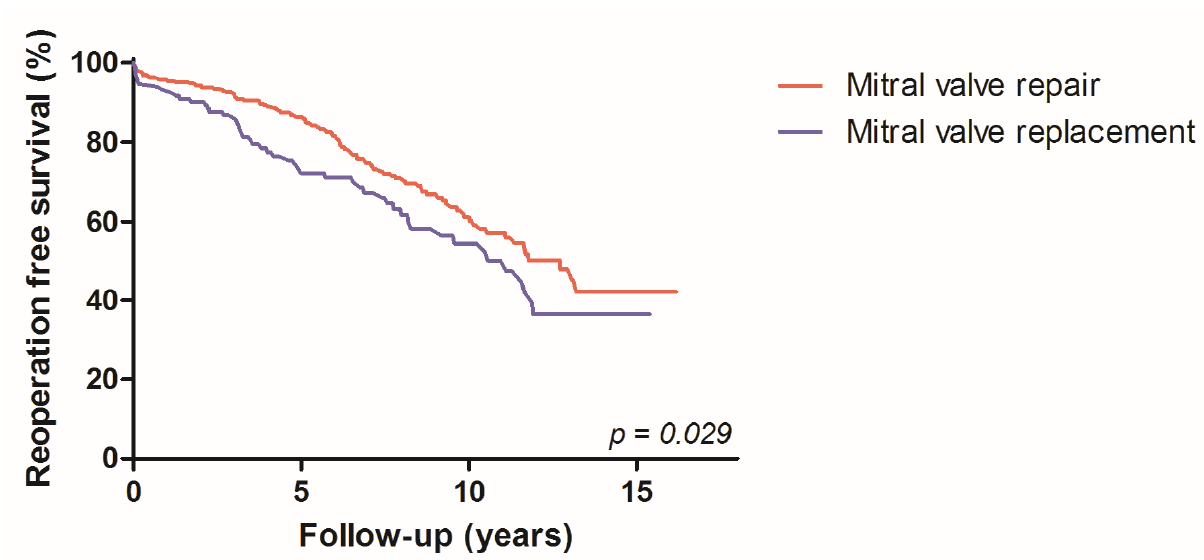
Figure 3. Kaplan–Meier curves: reoperation-free survival benefit of MV repair.